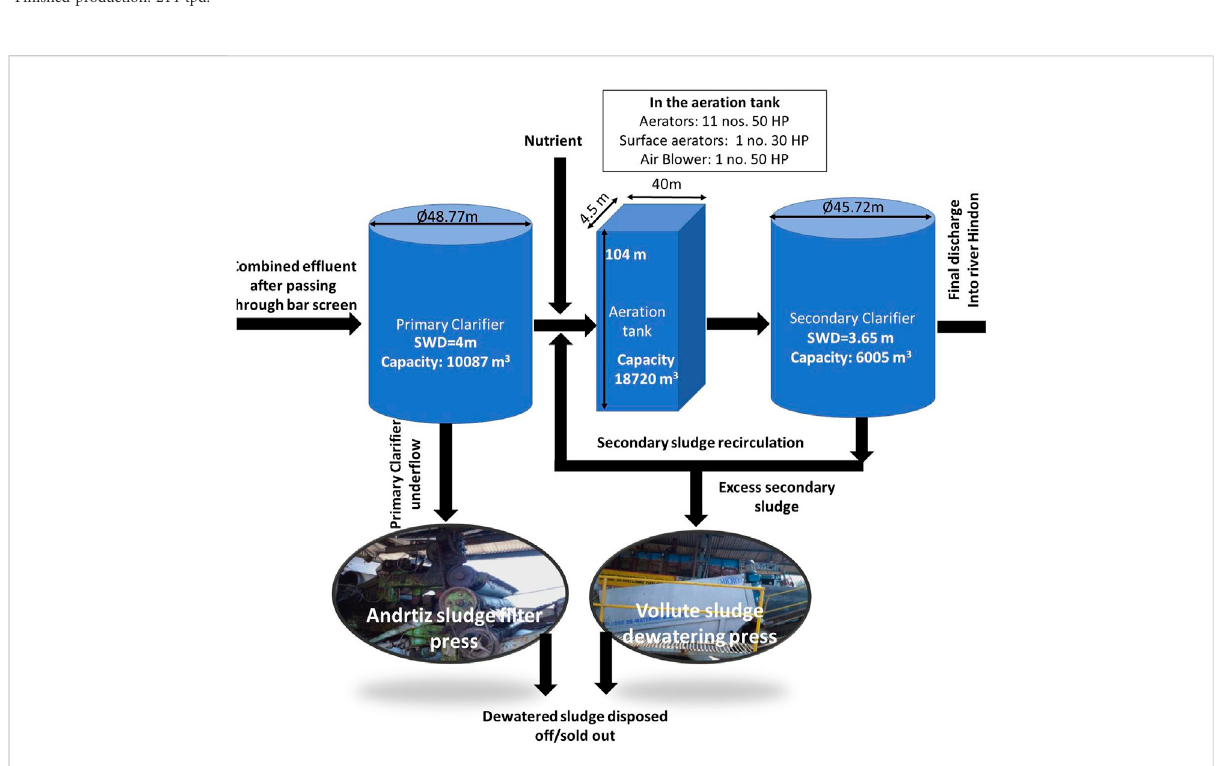
FIGURE 5 Layout of existing ETP at Star Paper Mills Ltd., Saharanpur, UP,